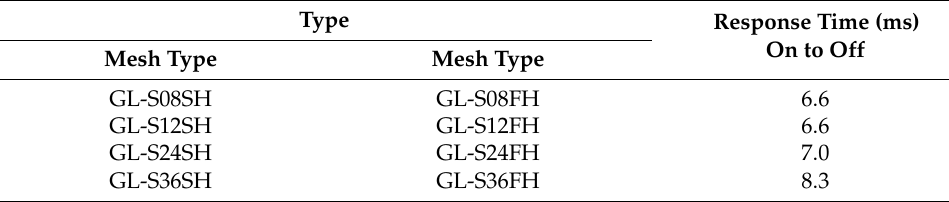
Figure 18. Overall detection time. Table 2. Keyence safety light grid response time.